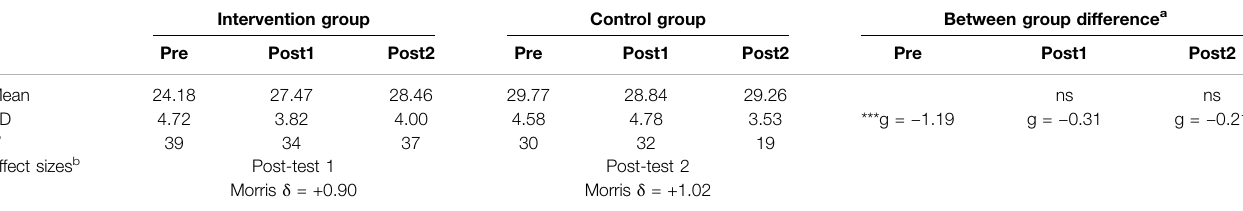
TABLE 5 | Teachers ’ collective ef fi cacy comparison between baseline, post-test 1 and post-test 2 (at the primary level).